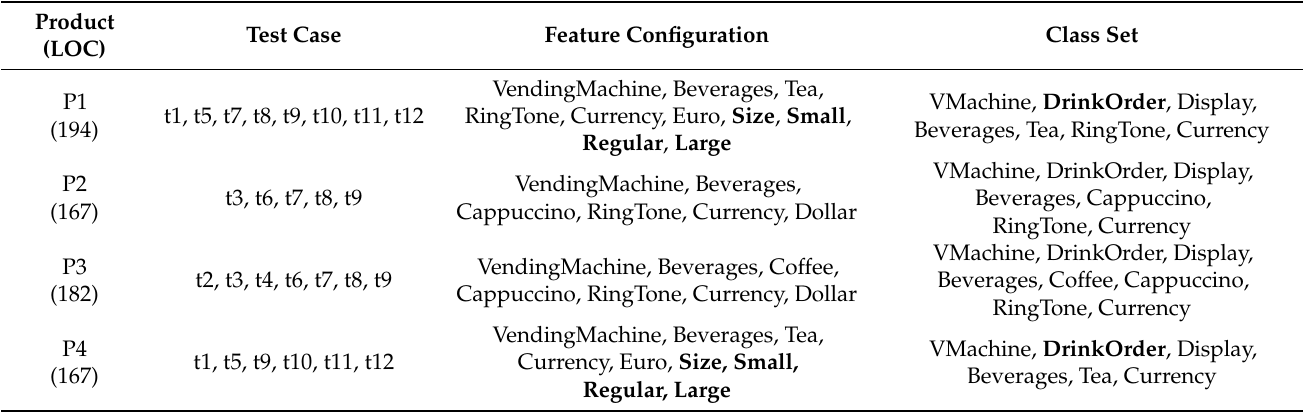
Table 7. A product family SPL V1 . Features or classes changed in SPL V0 are presented as bold type.